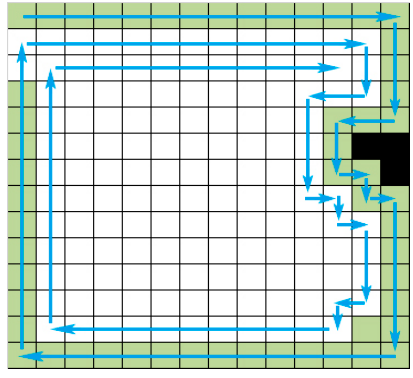
Figure 6. ISC traverse method.